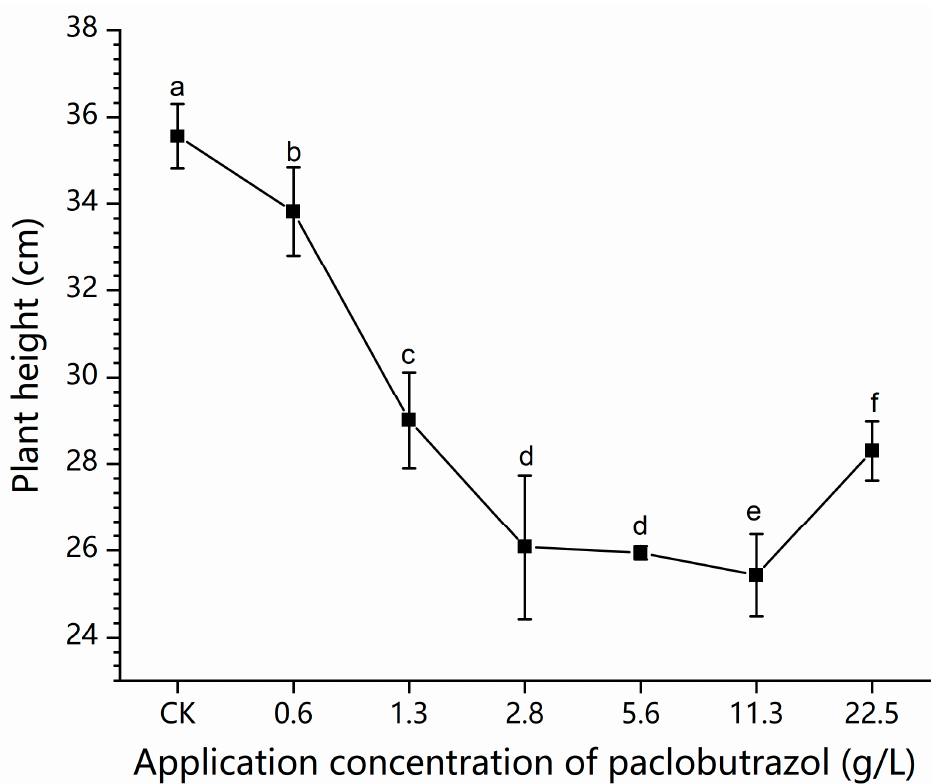
Figure 3. Effects of different concentrations of paclobutrazol on the plant height of O. japonicus. Different letters (a–f) represent significant differences ( p ≤ 0.01) across treatments according to Tukey’s SD test. Vertical bars represent standard errors.